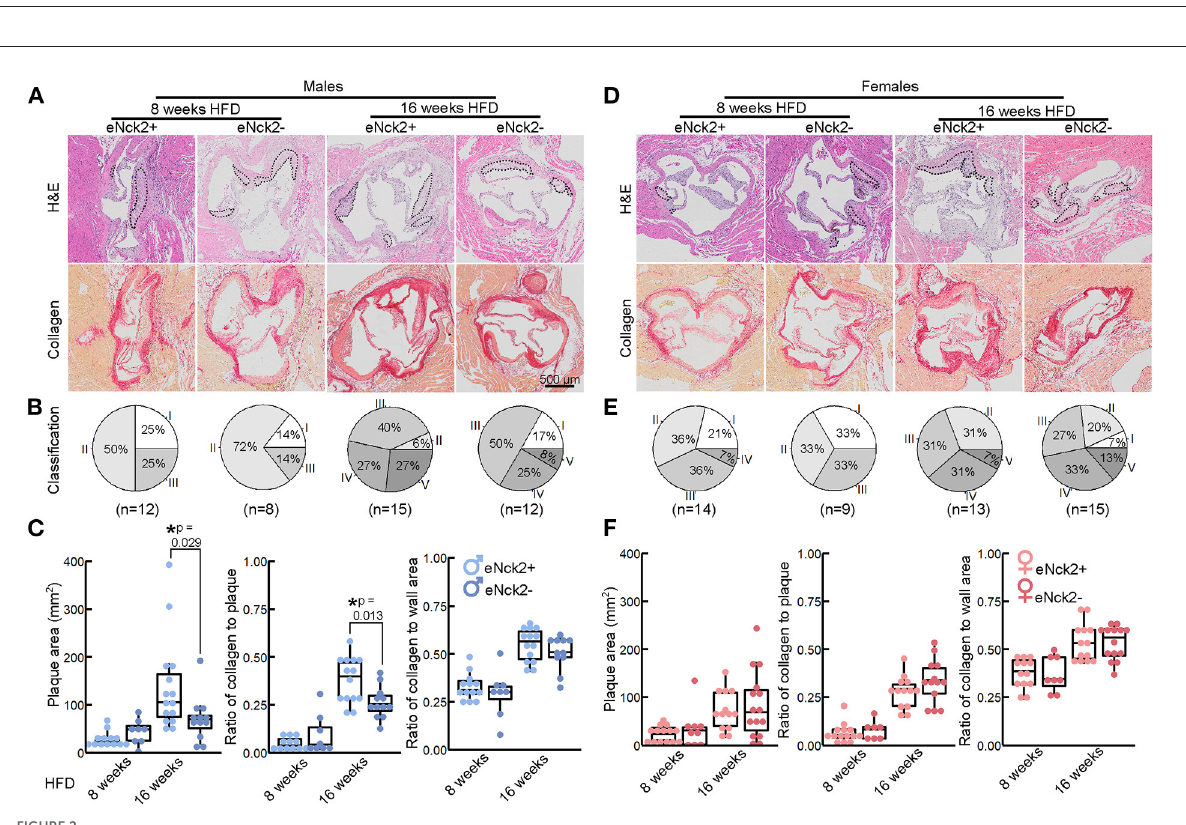
FIGURE2 Morphometric analysis of aortic root lesions in atheroprone male and female mice with and without endothelial-specific deletion of NCK2. Animals were fed a HFD for 8 or 16 weeks to assess atherosclerotic lesion initiation and progression, respectively. (A,D) Representative images of aortic roots stained with H&E (top) and Picrosirius Red (bottom) to assess lesion development and collagen deposition, respectively. The scale bar represents 500 µ m. (B,E) Pie charts showing percentage of lesion category in each experimental group. Lesions were classified as intima thickening (type I), fatty streaks (type II), intermediate lesion (type III), advanced atheroma (type IV), and fibroatheroma (type V). Numbers of animals/group are indicated in parentheses. (C,F) Box plots showing quantification of plaque area, ratio of collagen to plaque area, and ratio